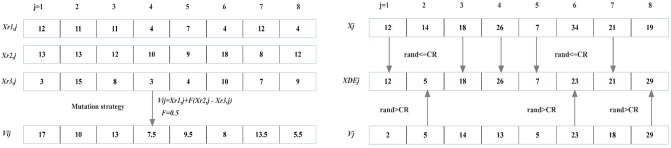
The procedures of mutation and crossover strategies.(A) The procedures of mutation strategy. (B) The procedures of crossover strategy.